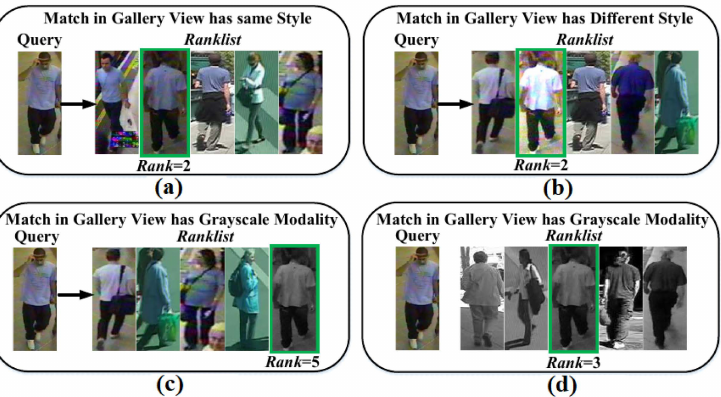
Figure 12. Retrieval results obtained in challenging close-set scenario. ( a ) Finding the match in Gallery view where the correct Gallery image has same style and modality with Query image; ( b ) Finding the match in Gallery view where the correct Gallery image has different style, but, same modality with Query image; ( c ) Finding the match in Gallery view where the correct Gallery image has different style, and different modality with Query image; ( d ) Finding the match in Gallery view where all the images in Gallery view has different style, and different modality with Query image.